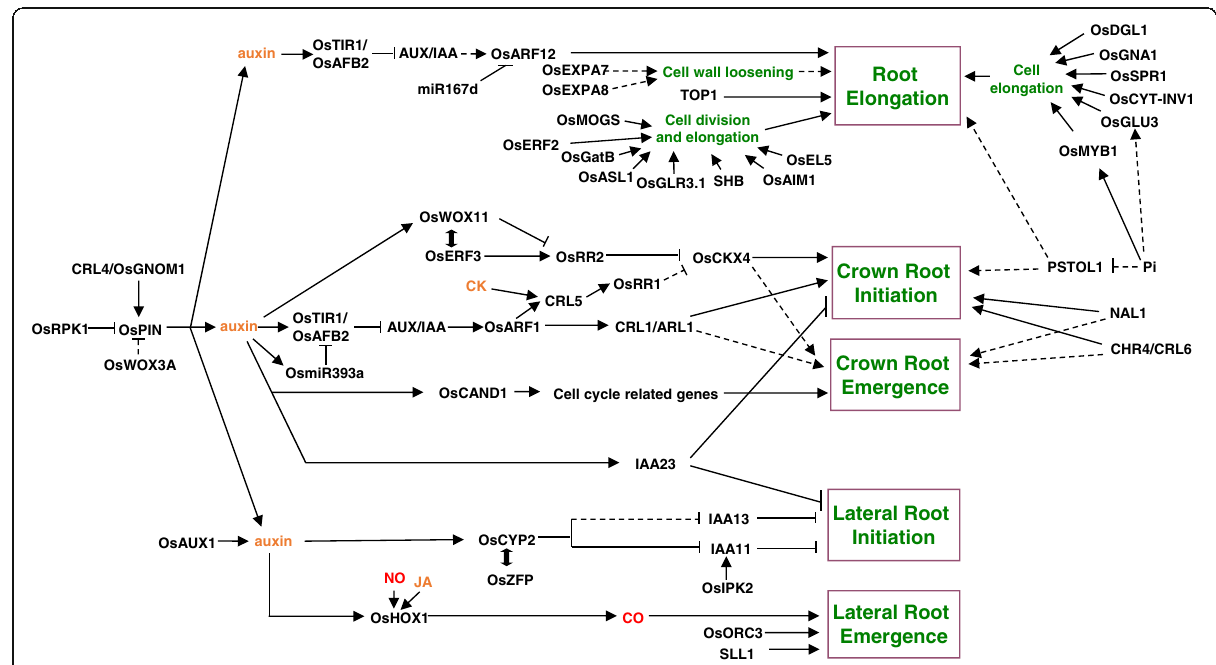
Fig. 1 The molecular regulatory mechanisms of root development in rice. Arrows represent positive regulatory actions. Lines ending in a flat head indicate a negative regulatory action. Dashed lines represent interactions that have not been experimentally confirmed. Double-headed arrows indicate that two proteins interact. Text color code: genes or protein, black; hormones, yellow; signals, red; biological processes,